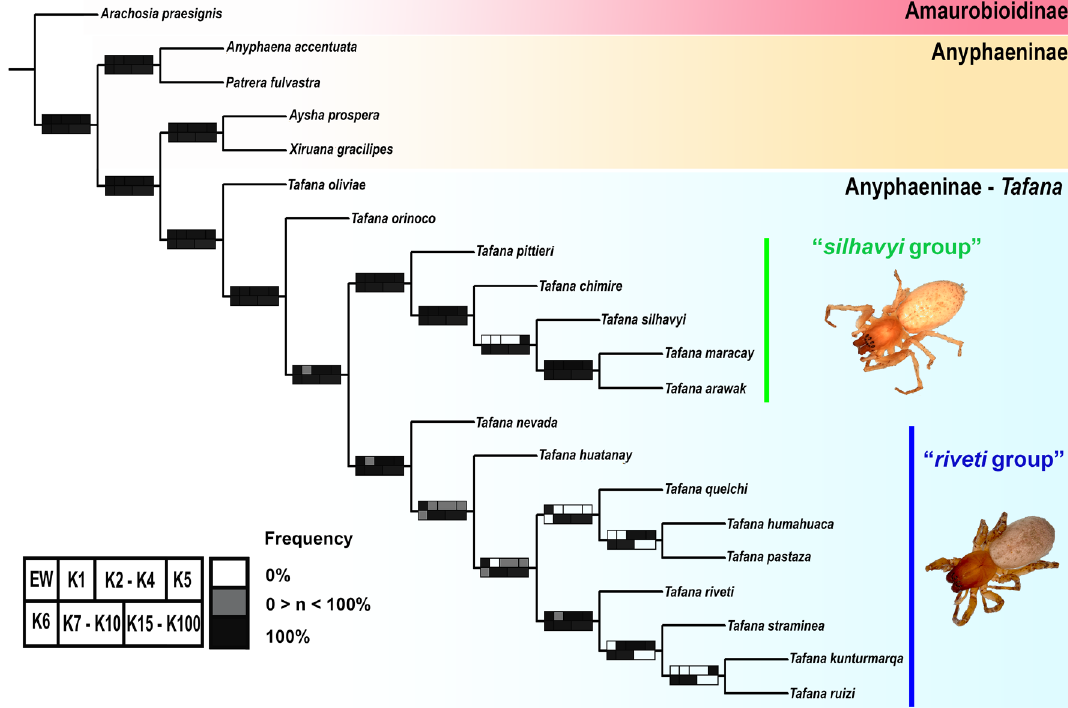
Fig. 4. Topology obtained under k = 7 (Fit = 27.319). The squares on the branches represent the sensitivity of the clade to different k